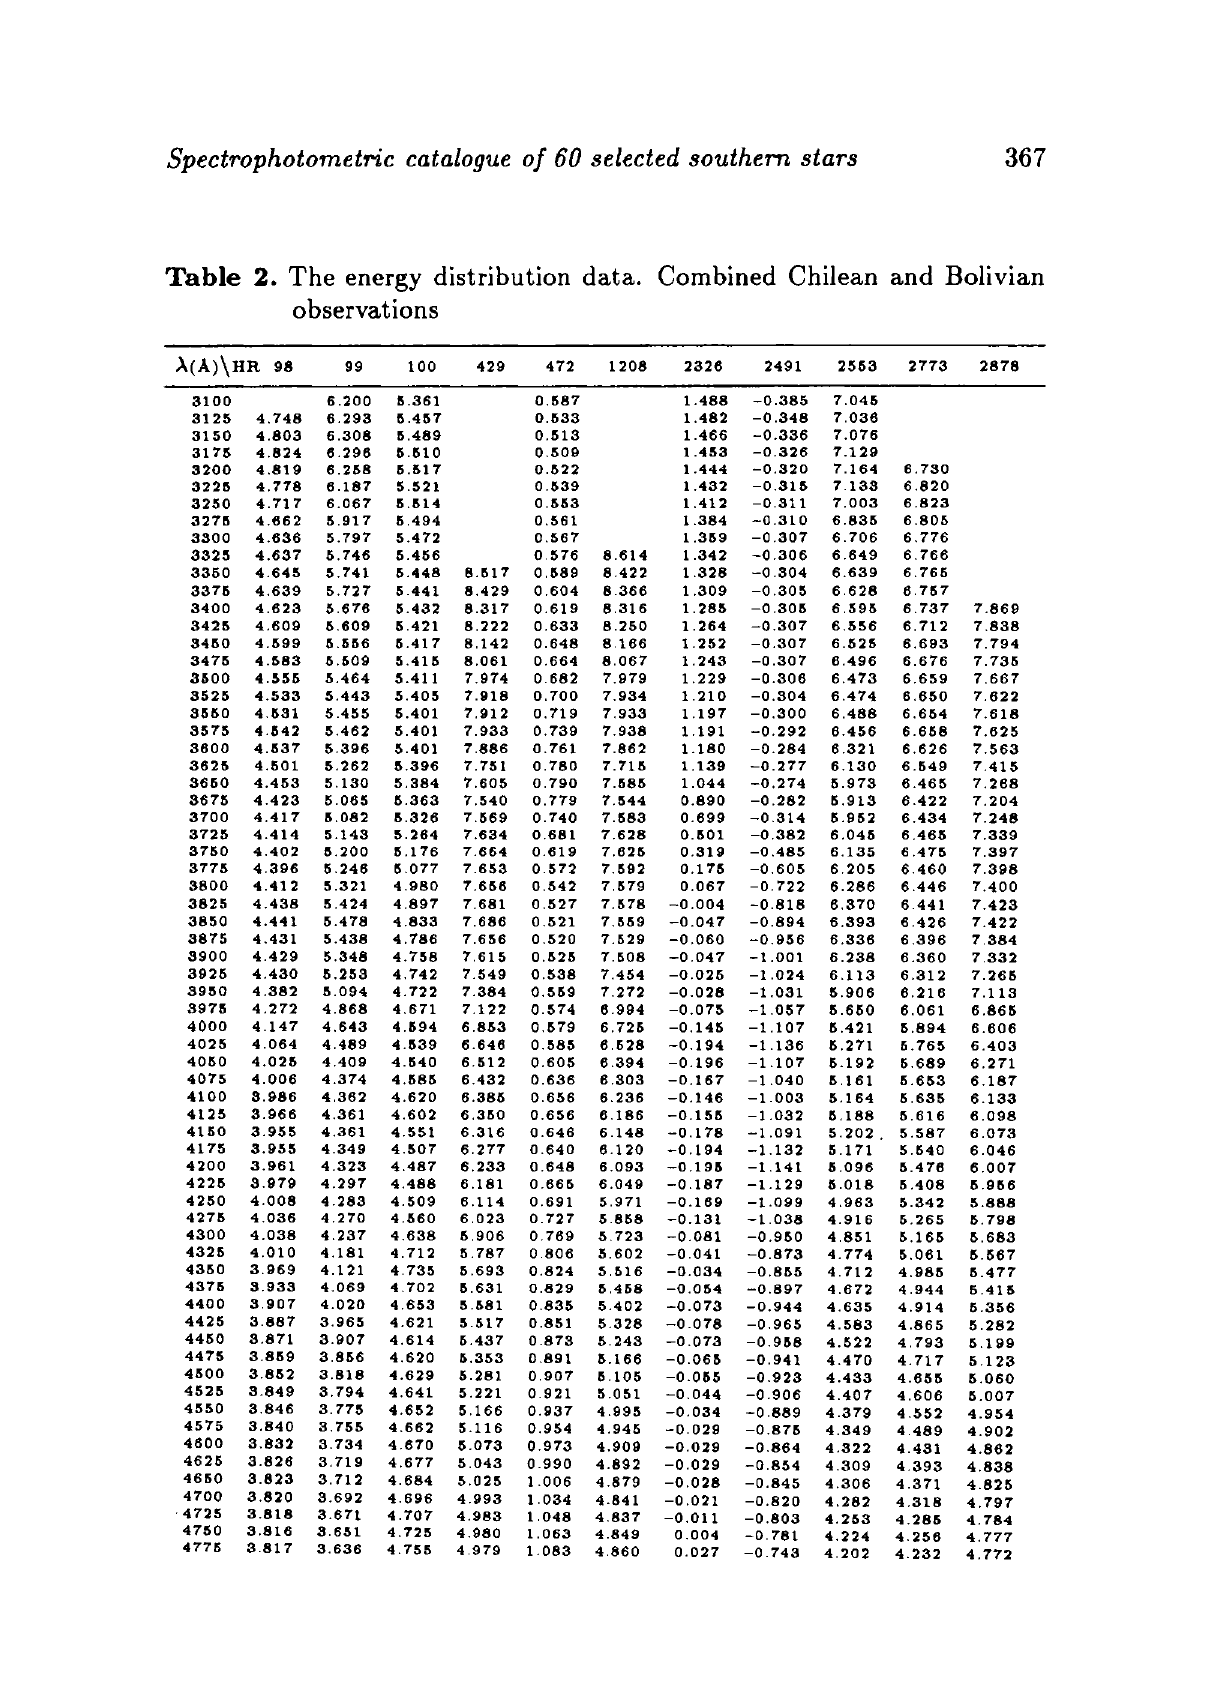
Table 2. The energy distribution data. Combined Chilean and Bolivian